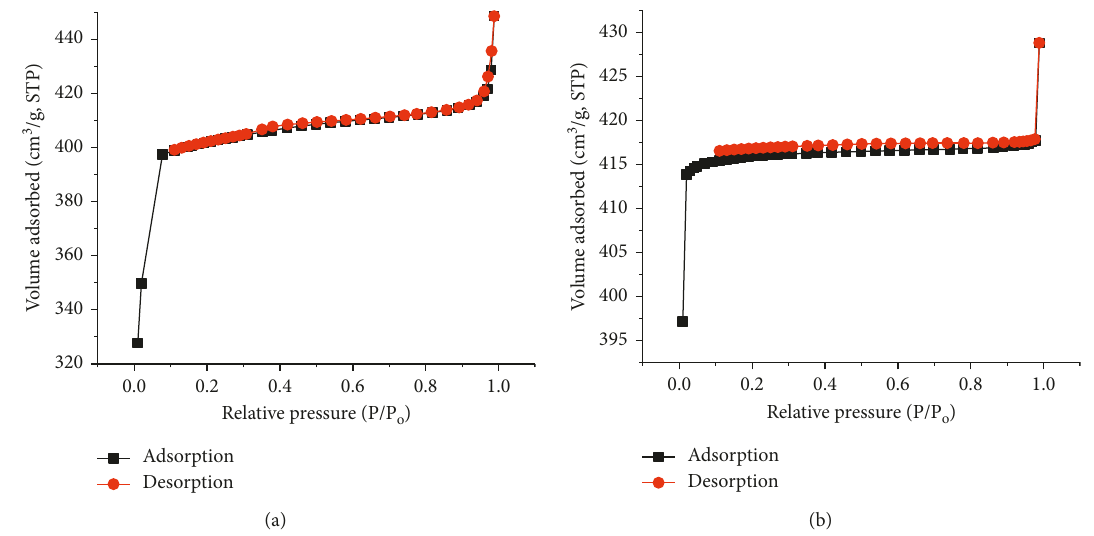
Figure 3: Nitrogen adsorption/desorption isotherms of Z-A(MeOH) sample (a) and Z-B(DMF) sample (b). Table 1: Porous properties of ZIF-8 samples. Sample